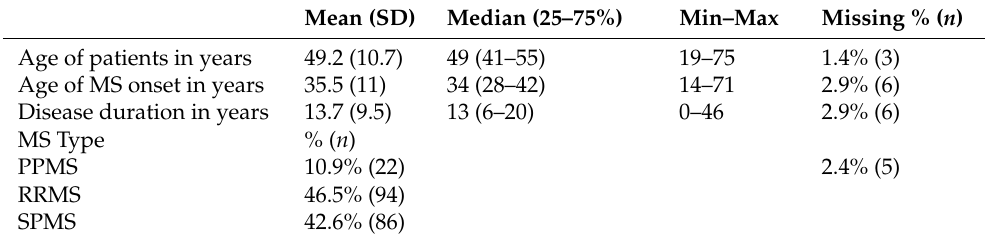
Table 1. Patient and disease